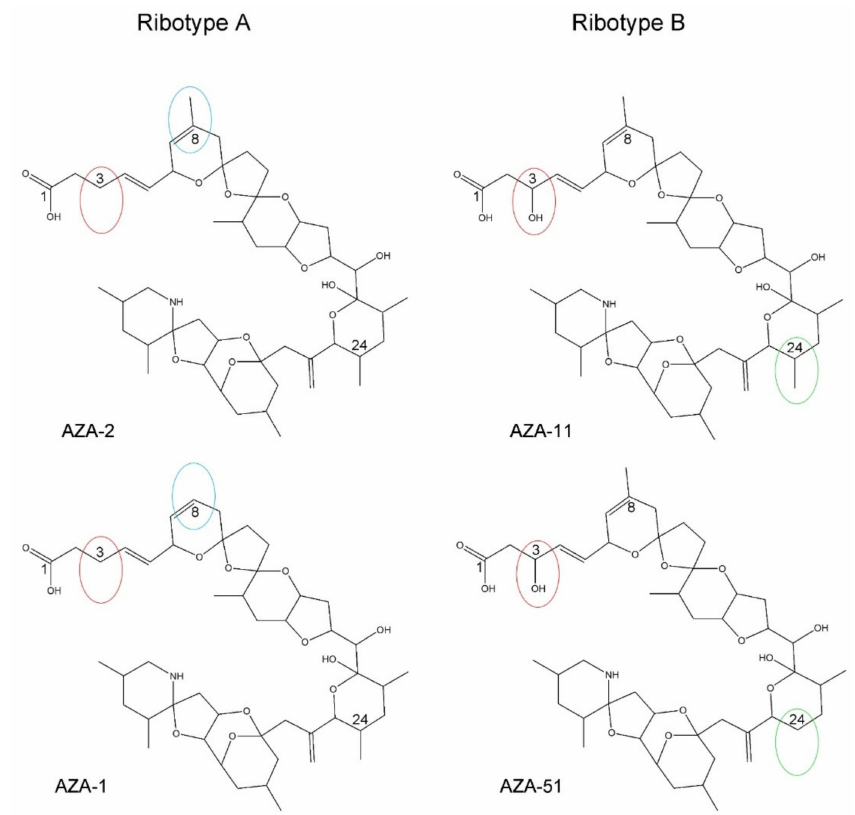
Figure 14. Planar structures of AZA-1, AZA-2, AZA-11, and AZA-51. All AZA are closely related and can be regarded as variants of AZA-2: AZA of ribotype B are hydroxylated at C3 (red ovals), whereas ribotype A AZA are not. AZA profiles of both ribotypes consist of a base compound (AZA-2 and AZA-11, respectively) and a demethylated variant (AZA-1 and AZA-51, respectively). The demethylation site of ribotype A AZA is C8 and of ribotype B C24 (green